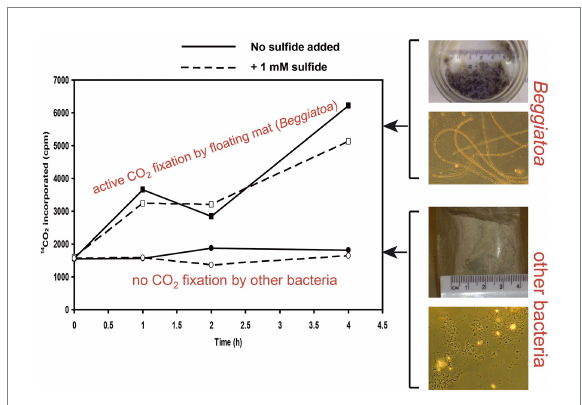
FIGURE 4 Incubation of Ayyalon microbiota, sampled from the sulfidic cave pond, with 14 C-labelled bicarbonate. On the right, pictures show bulk samples as sampled within glass bottles, and microscopic view of Beggiatoa sp. and other bacteria. On the left, upper lines show active CO 2 fixation by Beggiatoa sp. of the microbial mat sampled from the top of the water column. Lower lines indicate no carbon fixation by other bacteria sampled from the water body. Beggiatoa vs. other bacteria were differentiated by morphology and sulfur content. The increase of radioactivity of the microbial lipids during incubation indicates uptake of the radiolabeled bicarbonate by Beggiatoa , suggesting that these sulfur-oxidizing microorganisms use the water-dissolved inorganic carbon for chemolithoautotrophic carbon fixation. The experiment was performed with and without adding sulfide (dashed and solid lines respectively), showing similar